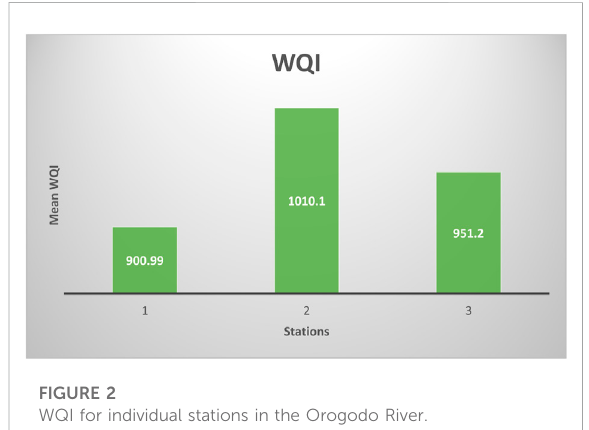
FIGURE 2 WQI for individual stations in the Orogodo